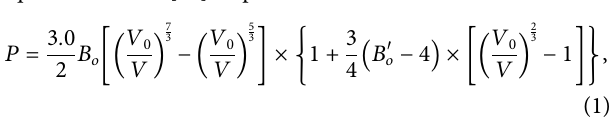
Frontiers in Physics |